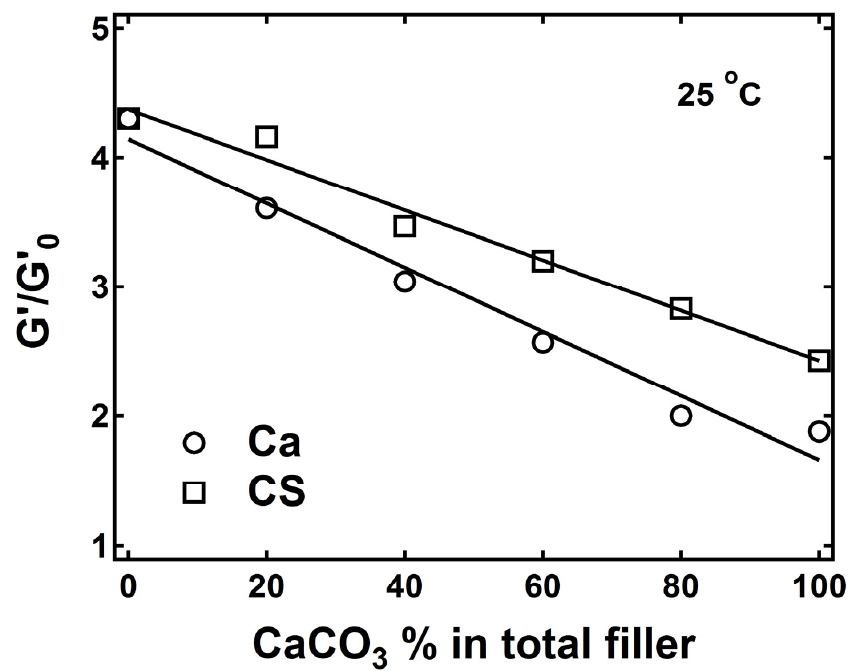
Figure 2. Reinforcement factors of protein and calcium carbonate reinforced NR with 50 phr filler.